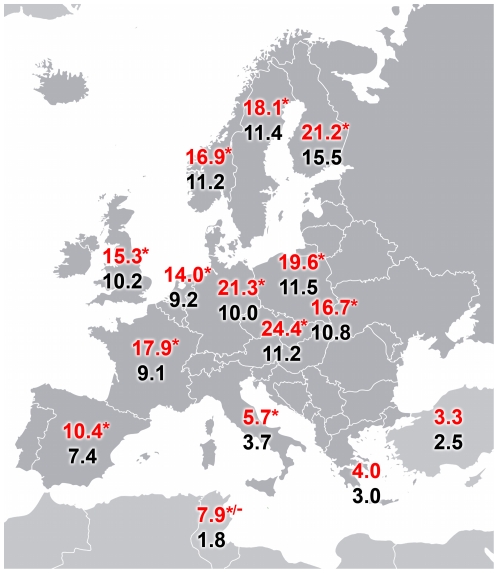
Geographical distribution in Europe.Geographical distribution of the T allele frequency at PTPN22 rs2476601 SNP in European RA patients (red) and healthy controls (black) [5], [7]–[9], [16]–[37]. The ‘*’ symbol refers to countries in which a statistical significant different distribution of the PTPN22 T1858 allele among patients and controls was noted. In Tunisia the two existing articles regarding PTPN22 show opposite findings.